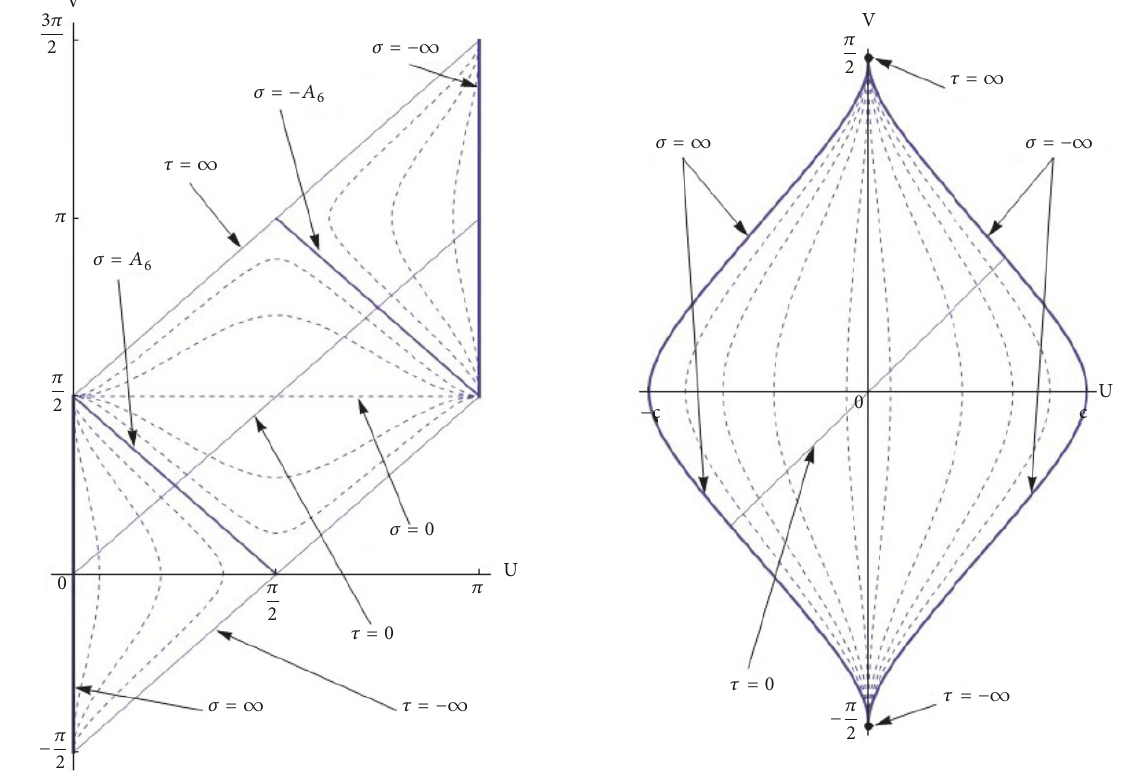
Figure 5: The left diagram corresponds to 𝐴 2 6 > 0 , with a subsequent causal structure which is divided into two regions by the 𝜎 = 𝐴 6 curve. The end points of the worldsheet, denoted by 𝜎 = ±∞ , corresponds to two fundamental degrees of freedom with opposite charges. The right Penrose diagram corresponds to 𝐴 2 6 < 0 , and the resulting causal structure does not possess any event horizon. Dashed lines on both diagrams correspond to curves with constant 𝜎 . This diagram is taken from [77], with the authors’